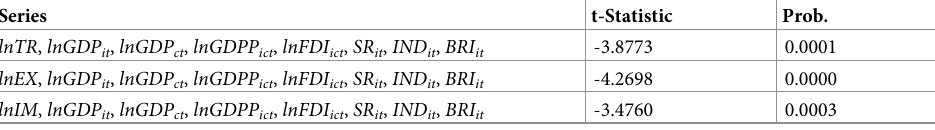
Table 6. Results of Kao Residual cointegration